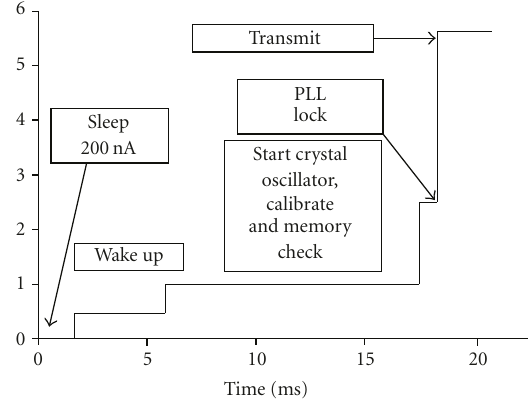
Figure 3: Implant wakeup sequence and current consumption.